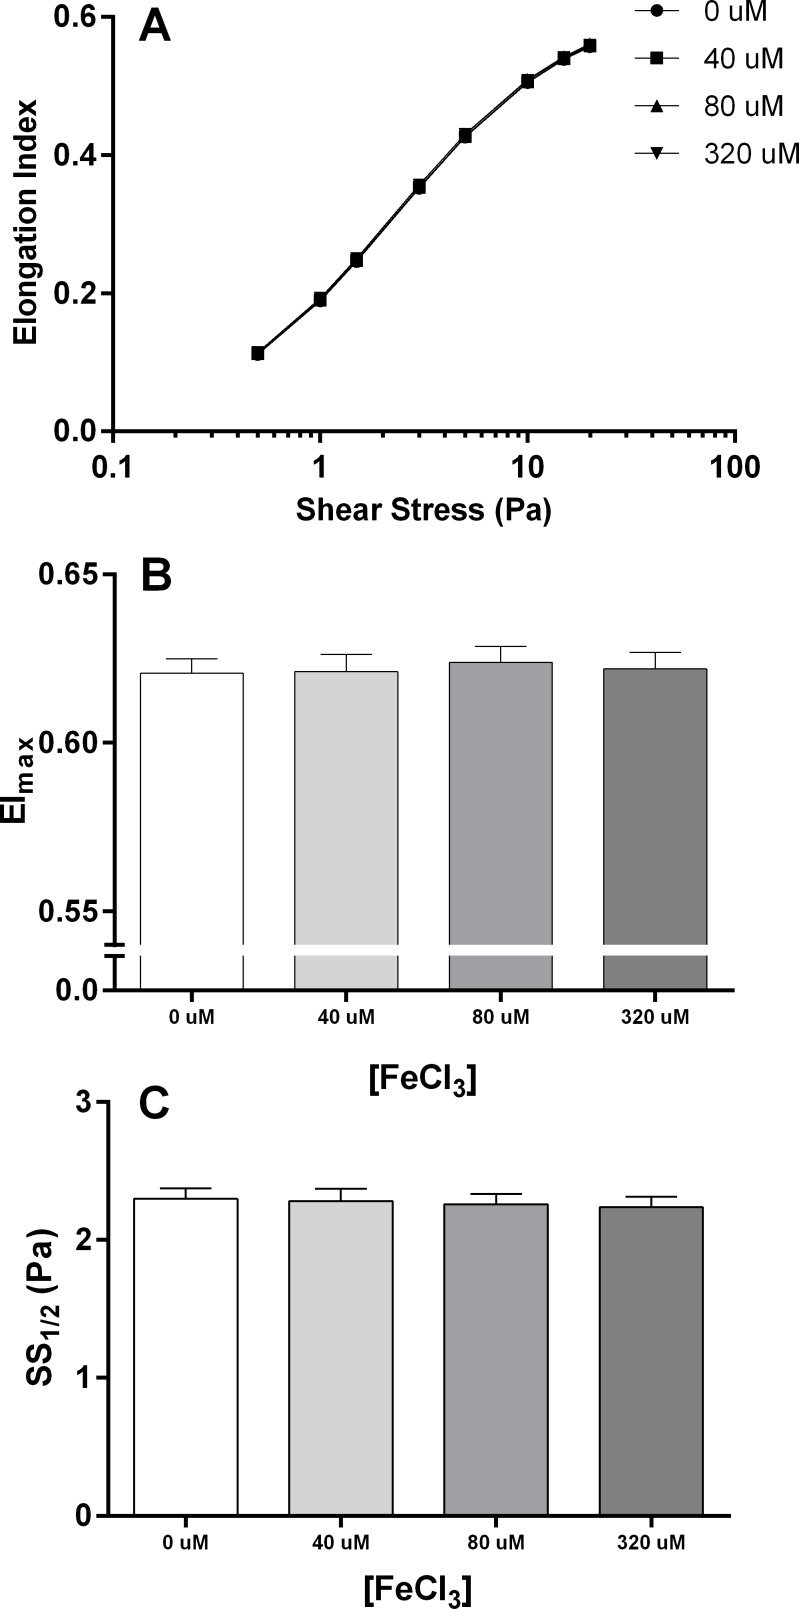
The Elongation Index (EI) of RBC in autologous plasma at varying shear stresses (Panel A) following an incubation with varying concentration of FeCl3 (0, 40, 80, 320 uM).The varied iron incubated conditions did not influence the maximal EI (EImax; Panel B) or the amount of shear stress required for half maximal EI (SShalf; Panel C).